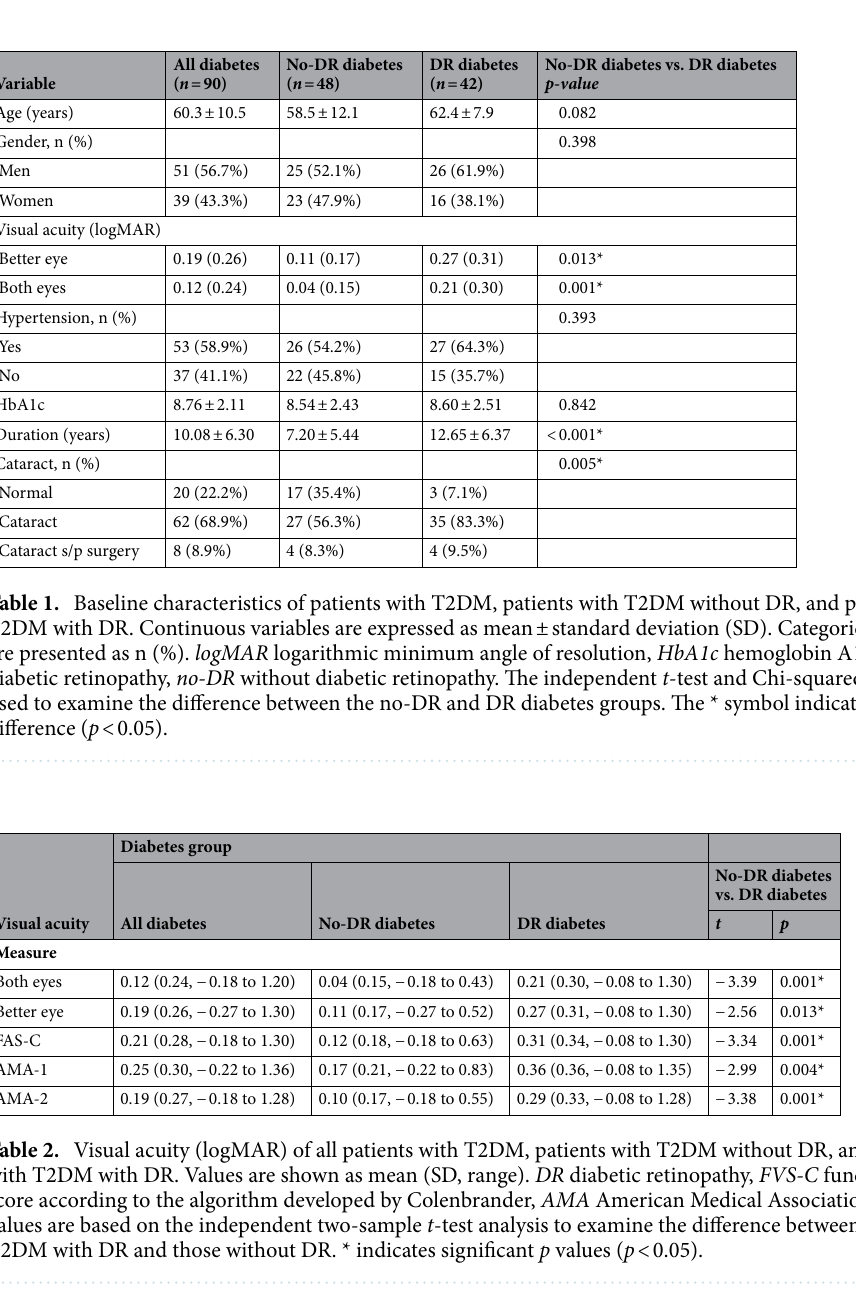
Descriptive analysis and mean comparison of visual acuities. Table 2 shows the visual acuities of all patients with T2DM, those without DR, and those with DR in the better eye and both eyes, as well as the weighted acuities with the FAS-C, AMA-1, and AMA-2 algorithms. The average acuities of both eyes were consistently better than those estimated by other methods. These five types of acuity assessment were significantly lower in the no-DR group than in the DR group (e.g., both eyes: independent two-sample t -test = − 3.39; p = 0.001). Descriptive analysis and mean comparison of the NEI VFQ‑25. The distributions of the NEI VFQ- 25 subscale and composite scores in all patients with T2DM, those without DR, and those with DR are presented in Appendix Table 1. The averaged composite scores were 84.31 (SD = 13.09) for the all patients with T2DM group, 87.46 (SD = 8.48) for the no-DR group, and 80.71 (SD = 16.27) for the DR group. The smallest scale scores